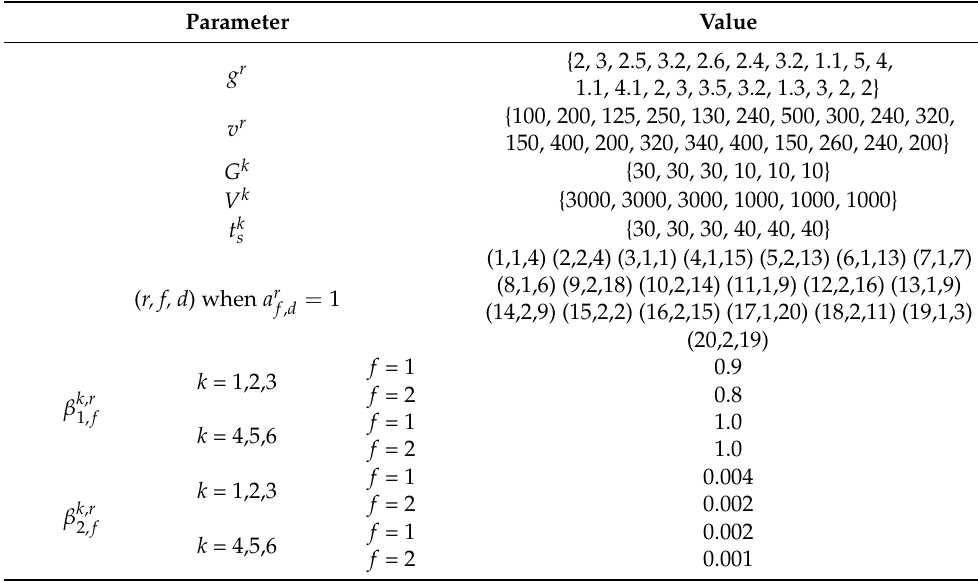
Table 2. System parameters for vehicles, orders, and